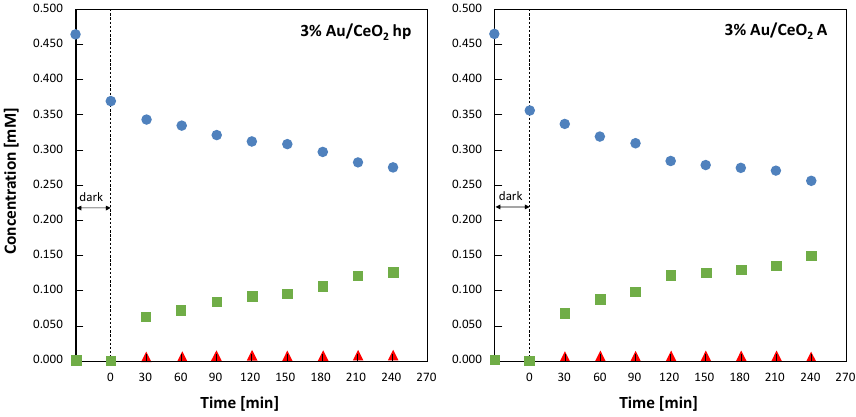
Figure 8. Natural solar light assisted partial photocatalytic oxidation of 4-MBA in the presence of the 3% Au-loaded CeO 2 samples. Evolution of 4-methoxybenzyl alcohol concentration ( ● ), 4-meth- oxybenzaldehyde ( ■ ) and 4-methoxybenzoic acid ( ▲ ) versus natural sunlight irradiation time. From the results reported in Figure 8, it was possible to calculate the conversion of 4- MBA and the selectivity versus the formation of 4-MBAL and 4-MBAcid during the evo- lution of the reaction. These results are reported in Figure 9. Figure 9. Natural solar light assisted partial photocatalytic oxidation of 4-MBA in the presence of the 3% Au-loaded CeO 2 samples. Selectivity towards 4-methoxybenzaldehyde ( ■ ) and 4-methox- ybenzoic acid ( ▲ ) versus 4-methoxybenzyl alcohol conversion.